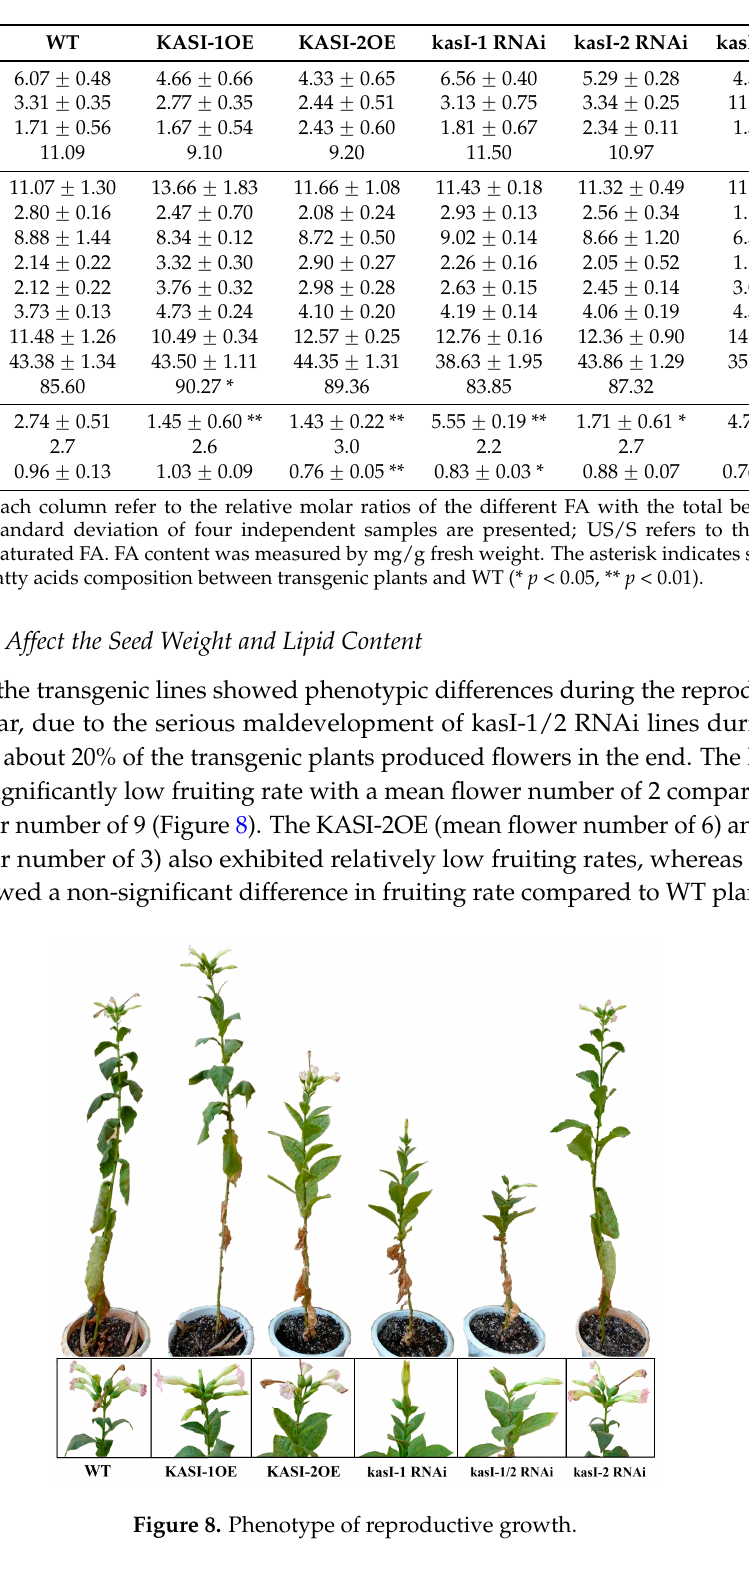
Table 1. Analysis of fatty acid methyl esters (FAME) of the total lipid extract from leaves of wild type (WT) and transgenic tobacco.